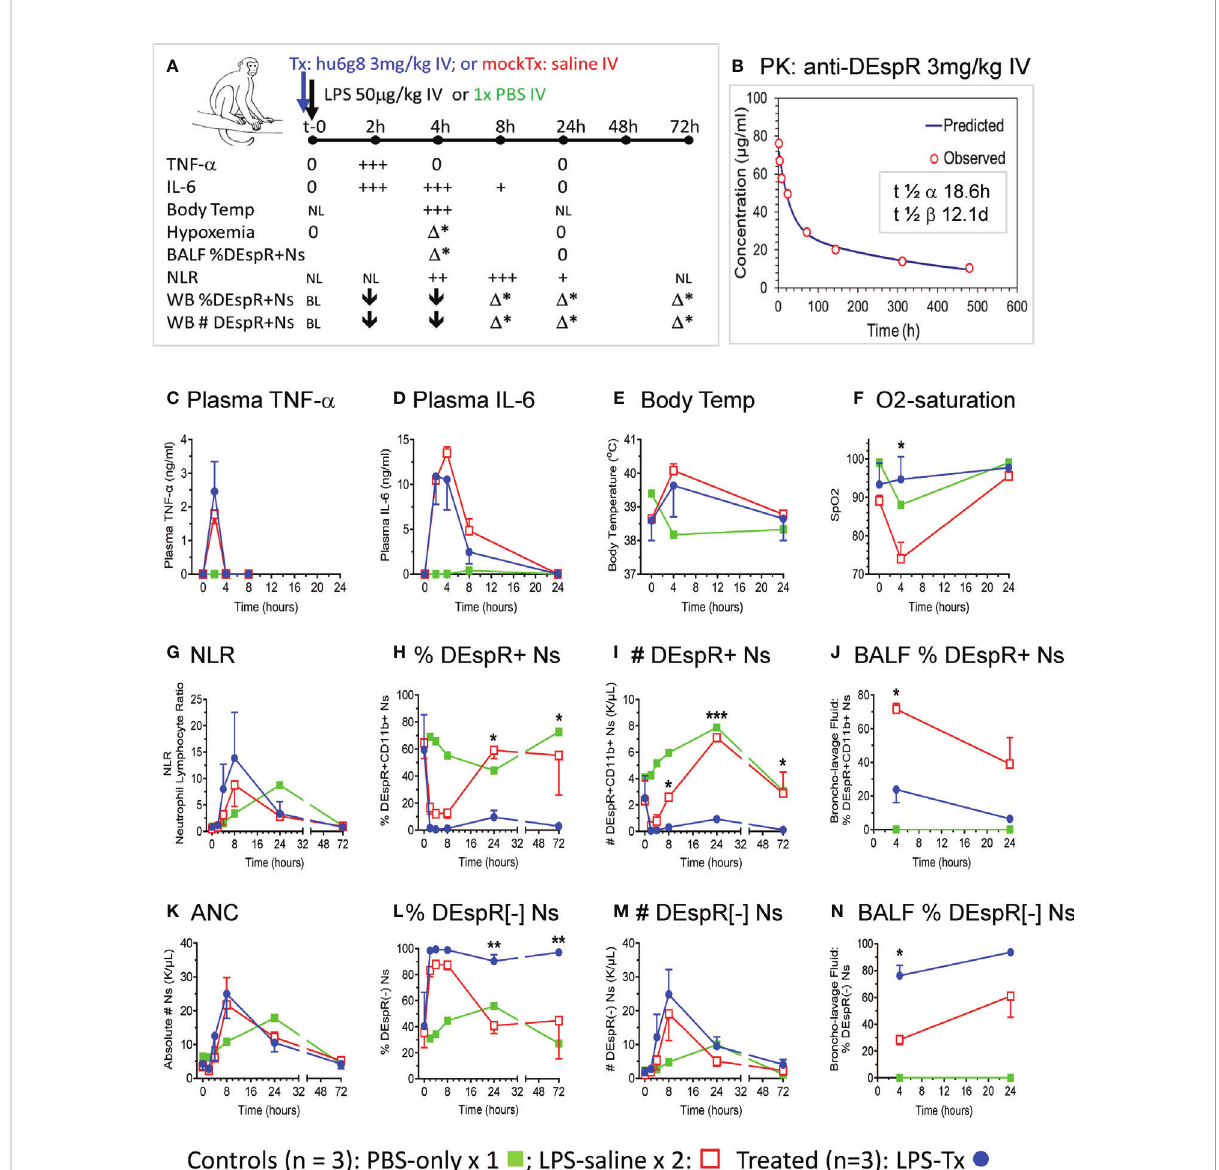
FIGURE 2 In vivo analysis in LPS-transient ALI rhesus macaque model studies. (A) Diagram of in vivo study along timeline, t-0 (baseline) to 72hrs with measures obtained. LPS [50 m g/kg] was infused intravenously (IV) after a IV single dose of humanized anti-DEspR (hu6g8) antibody (n = 3), or mock-treatment (Tx) saline for placebo LPS-control (n = 2). Non-LPS PBS-only (n = 1) served as negative control. Measures obtained at designated time points: plasma TNF- a , IL-6; body temperature (temp), hypoxemia (% O2-saturation), fl ow cytometry analysis of % DEspR+CD11b+ neutrophils (Ns) in BALF, bronchoalveolar lavage fl uid and whole blood samples, and absolute total number (#) of peripheral DEspR+CD11b+ neutrophils (K/ m L) in whole blood samples. BL, baseline levels, NL, normal levels; 0, zero levels; ↓ , decrease; + to +++, increased levels with higher +++; h, hrs; D *, signi fi cant change between treated and saline mock-treated macaques in corresponding parameter. (B) Pharmacokinetic analysis of anti-DEspR hu6g8 in macaques (n = 2) given 3 mg/kg dose IV. Half-life of distribution, t ½ a : 18.6 hours (h), half-life of elimination, t ½ b : 12.1 days (D) . Time points for human IgG4 ELISA measurements in another study group of macaques (n = 2): 2-, 4-, 8-, 24-, 72-, 144-, 312-, 480-hours. Time course of averages of different measures per study group plotted (C-N), n = 3 LPS + treatment (LPS-Tx), n = 2 LPS-saline control, n = 1 no-LPS, no treatment control. One-way repeated measures ANOVA, with Holm-Sidak pairwise comparisons performed, signi fi cant P values notated respectively. (C) ELISA plasma TNF- a (ng/ml); (D) ELISA plasma interleukin (IL)-6 (ng/ml); (E) body temperature (°C); (F) O2 saturation (SpO2): *, P = 0.03. (G) neutrophil-lymphocyte ratio (NLR), (H) peripheral % DEspR+CD11b+ neutrophils (Ns): 24h (*) P = 0.02; 72h (**) P = 0.03); (I) peripheral total number (#) of DEspR+CD11b+ Ns (K/ m L): 8h (*) P = 0.03; 24h (***) P = 0.0001; 72h (*) P = 0.01. (J) BALF % DEspR+CD11b+ Ns: 4h: (*) P = 0.02. (K) Peripheral absolute neutrophil counts (ANC), (L) % DEspR- negative [-] neutrophils (Ns): 24h (**), P = 0.008, and 72h (**) P = 0.007. (M) Peripheral number (#) of DEspR[-] Ns, and (N) BALF % DEspR[-] Ns: 4h (*) P =